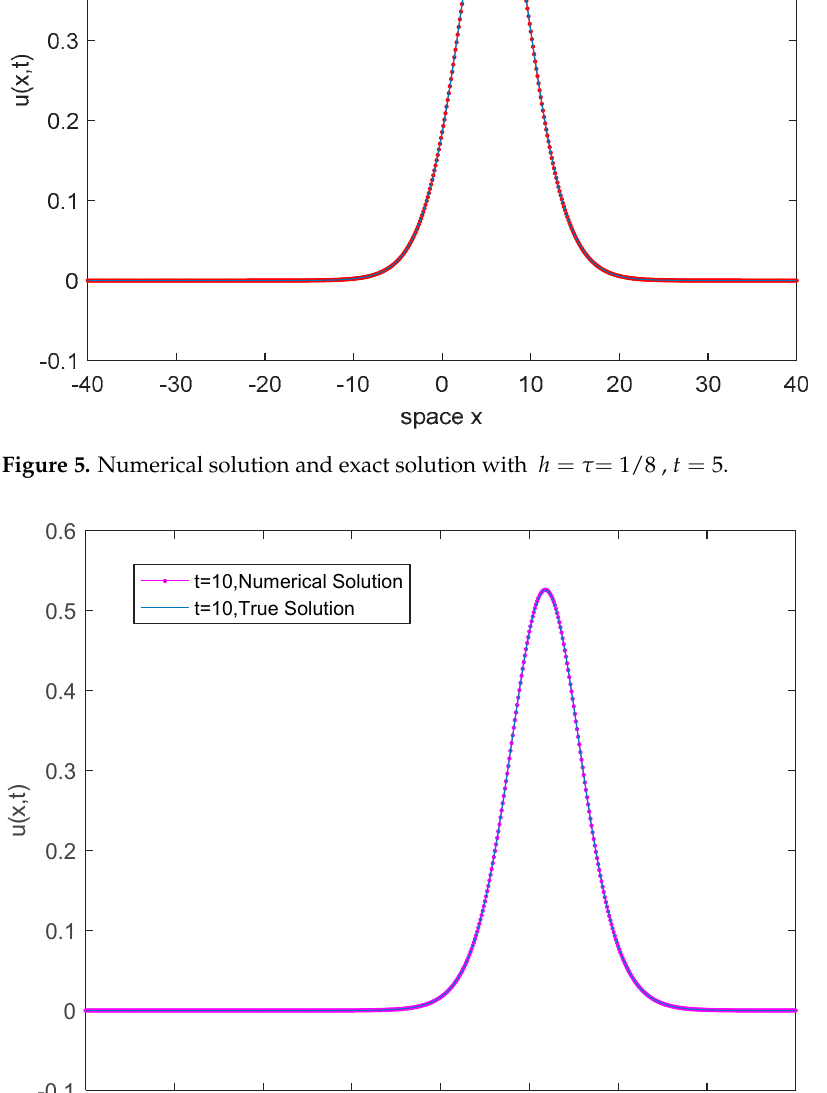
Figure 6. Numerical solution and exact solution with In Table 1, the errors with various h and τ are given. It is obvious that the